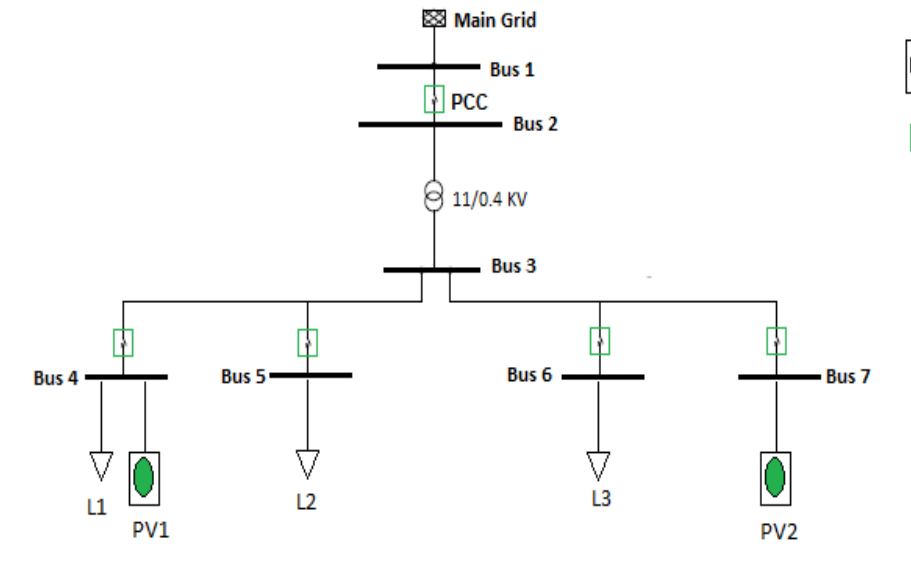
Figure 2. Bus topology of MG 1.